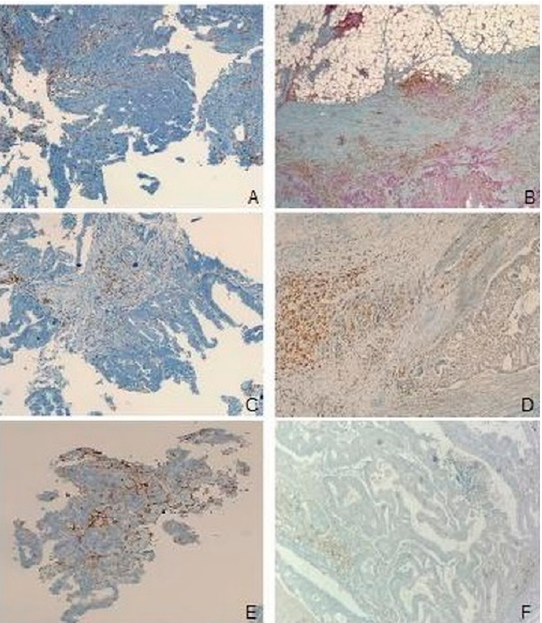
Figure 6. Absence of TME modulation in non ‐ IN patients. No changes in the lymphoid population between the biopsy ( A ) and the surgical specimen ( B ); preservation of TAM polarization in the biopsy ( C ) and in the surgical specimen ( D ). Higher PD ‐ L1 expression ( C ) and in the surgical specimen ( D ). Higher PD-L1 expression in both neoplastic cells and TME in both neoplastic cells and TME in the biopsy ( E ) and in the surgical specimen ( F ). ( A – in the biopsy ( E ) and in the surgical specimen ( F ). ( A – F ), immunohistochemistry: ( A , B ): CD4/CD8 F ), immunohistochemistry: ( A , B ): CD4/CD8 double stain; ( C , D ): CD68; ( E , F ): PD ‐ L1; double stain; ( C , D ): CD68; ( E , F ): PD-L1; O.M.: ( A , C – F ): 10 × ; ( B ): 4 × O.M.: ( A , C – F ): 10×; ( B ): 4×.